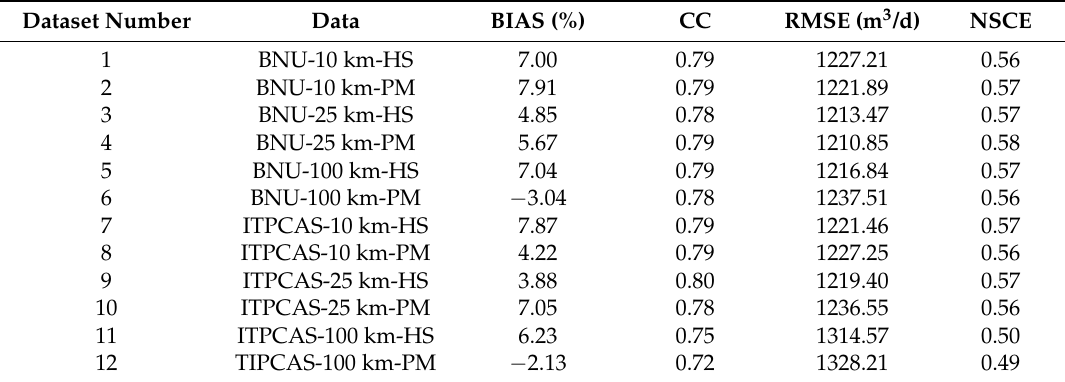
Table 3. Statistical summary of CREST 3.0 daily streamflow simulation evaluation by using different spatial resolution PET datasets from BNU and ITPCAS forcing data.